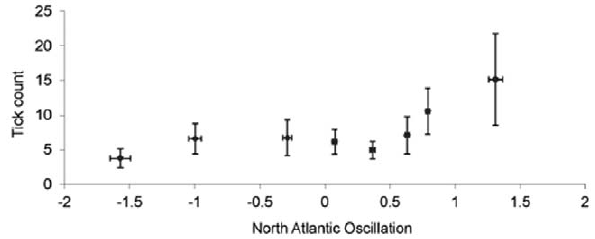
Figure 3. The North Atlantic Oscillation impacts tick counts on otters. Relationship of tick count to mean North Atlantic Oscillation at month of host death. Standard error bars shown.